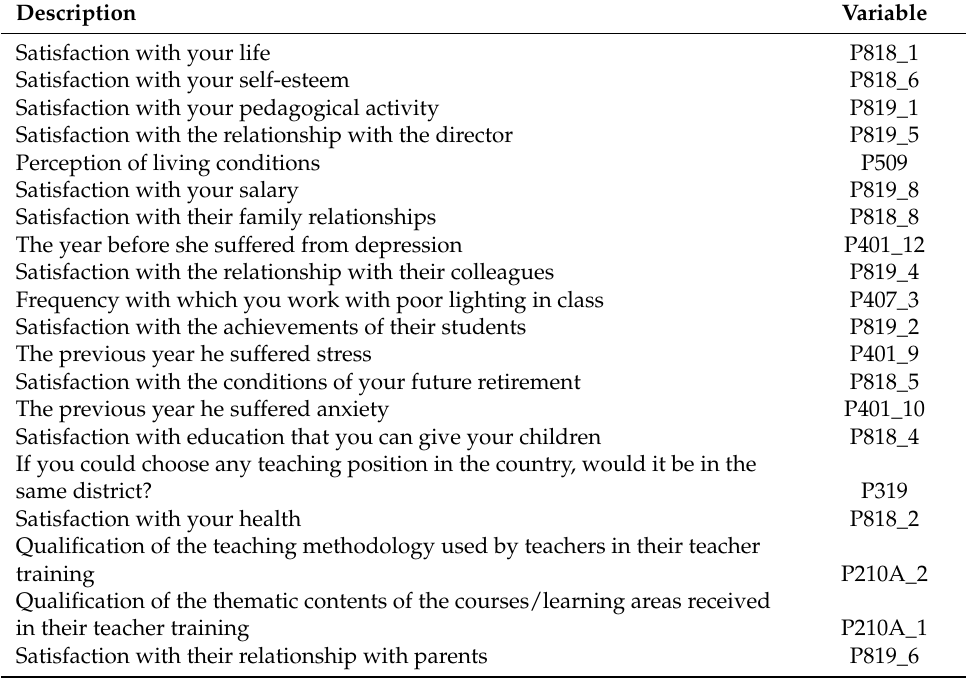
Table A2. Data dictionary of the features selected with the Chi-Square